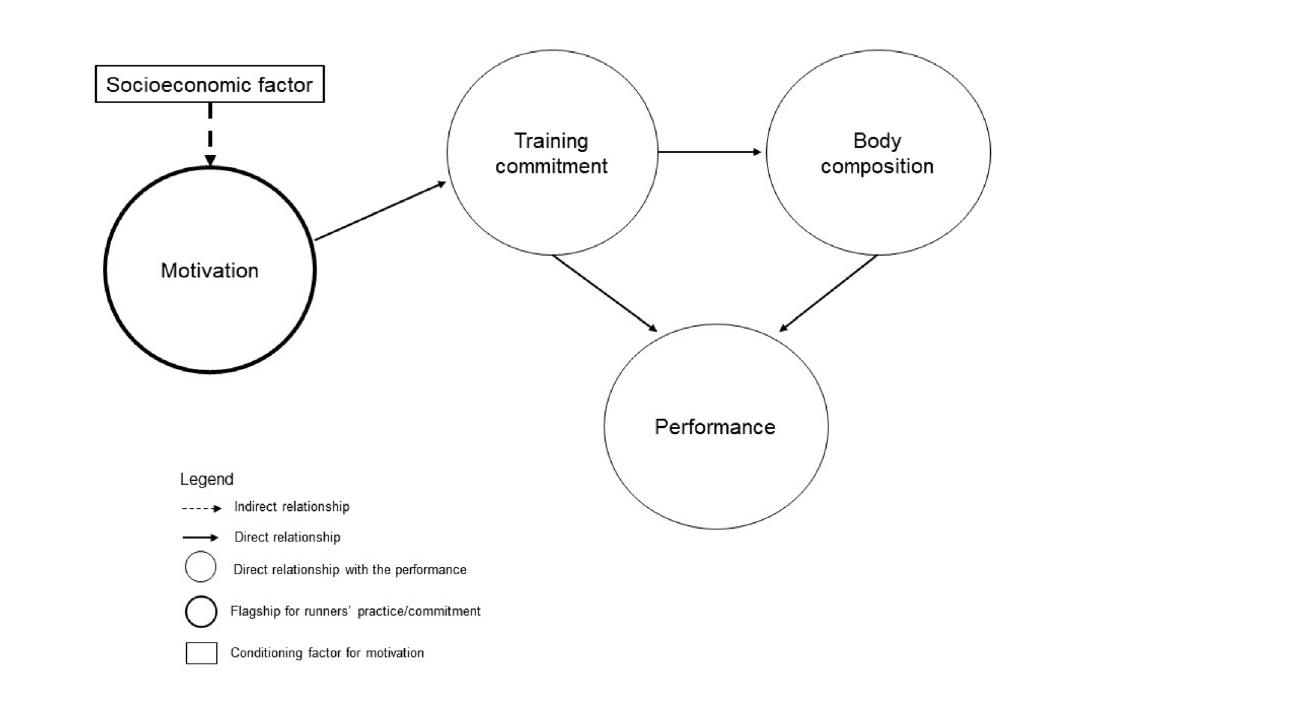
Figure 2 - Explanatory model to explain the relationship between variables used to the class differentiation and runners’